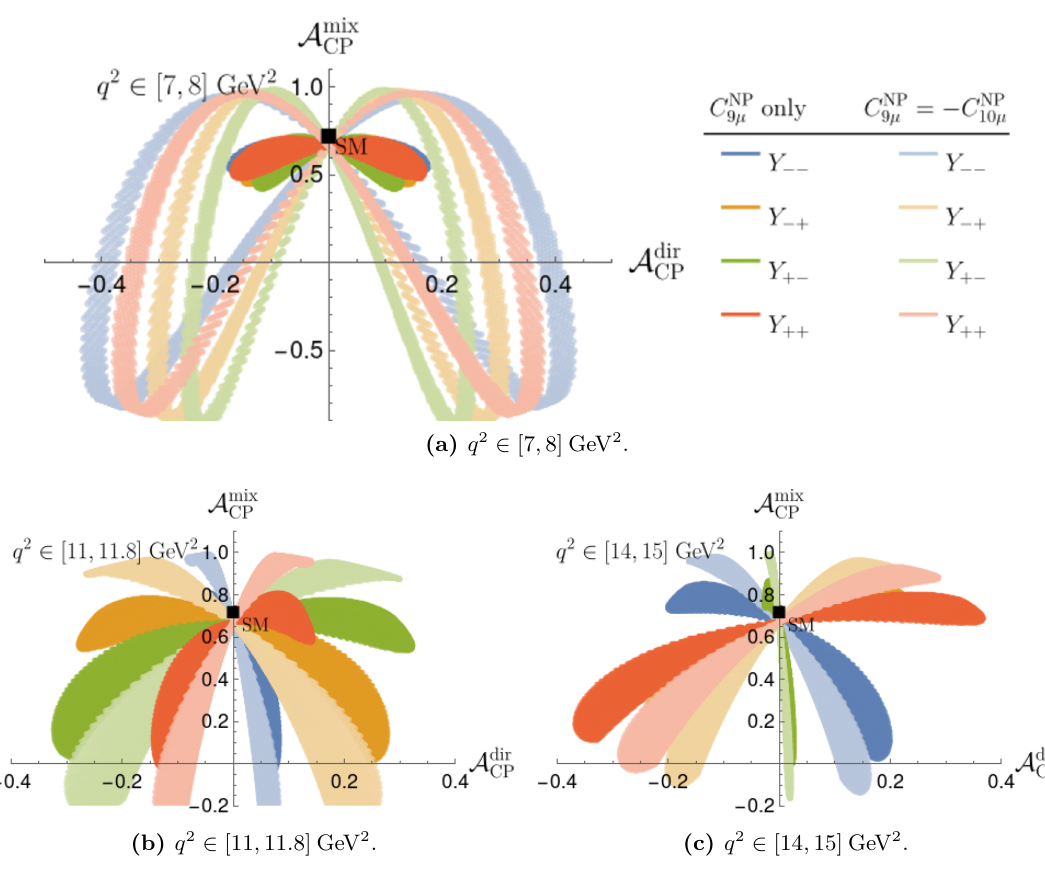
Figure 6 . Correlations between A dir long-distance branches.